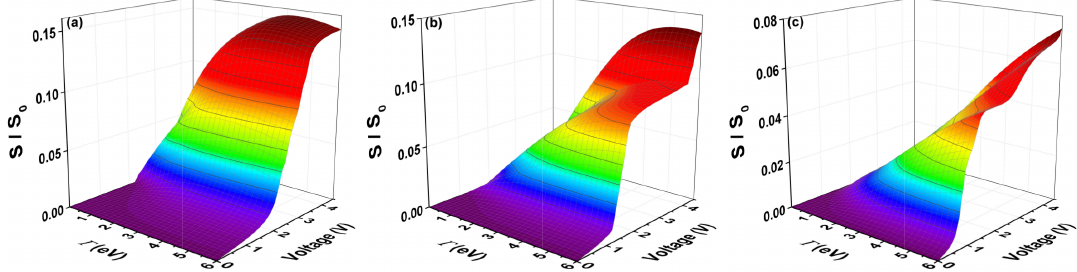
Figure 8. (color online) Shot noise ( S / S o ) as a function of bias voltage and the molecule–electrode coupling ( Γ ) for the molecular system with thiophene rings with ( a ) one ring; ( b ) two rings; and ( c ) three rings for E c = − 5.54 eV, E s = 0.98 eV, t d = t δ = t c = − 2.40 eV, and t τ = t s = − 0.83